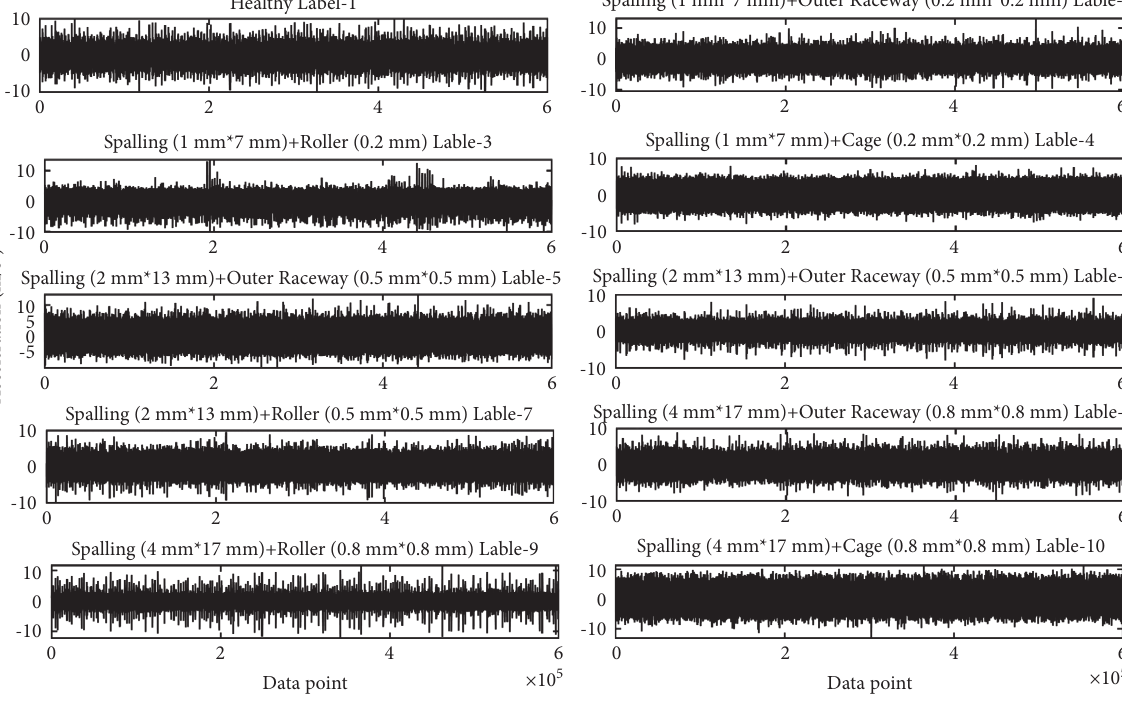
Figure 7: Vibration signals of the system with localized defects. Table 7: Composition of the diagnostic